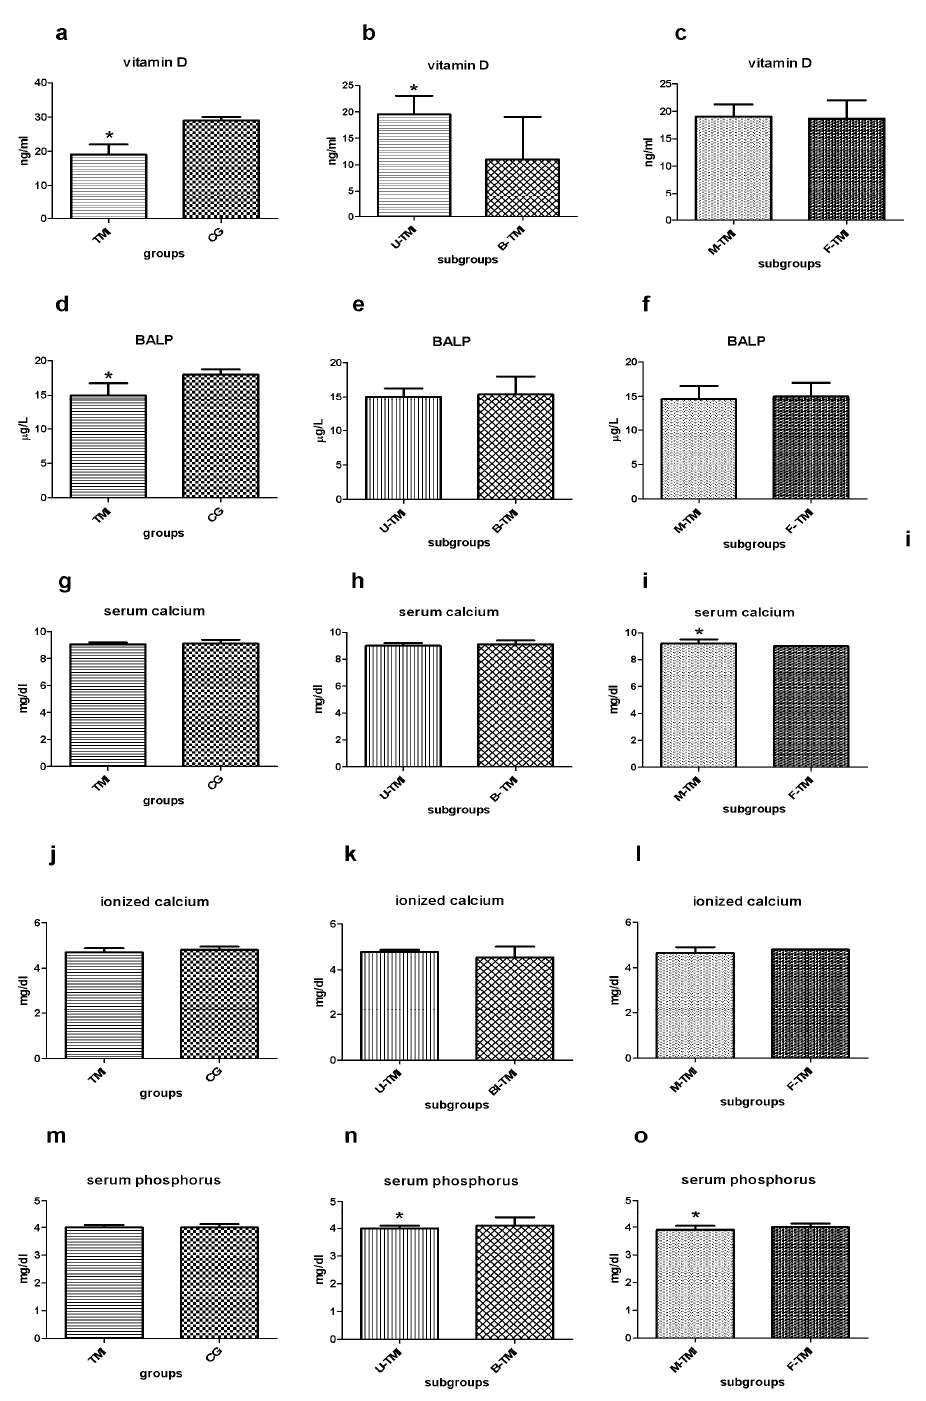
Figure 1. ( a – c ) Median with interquartile range of serum Vitamin D dosage (ng/mL) in TMI vs. CG ( a ), in U-TMI vs. B-TMI ( b ) and male vs. female TMI patients ( c ); ( d – f ) median with interquartile range of ionized calcium dosage ( µ g/L) in TMI vs. CG ( d ), in U-TMI vs. B-TMI ( e ) and M-TMI vs. F-TMI patients ( f ); ( g – i ) median with interquartile range of serum calcium dosage (mg/dL) in TMI vs. CG ( g ), in U-TMI vs. B-TMI ( h ) and male and female TMI patients ( i ); ( j – l ) median with interquartile range of ionized calcium dosage (mg/dL) in TMI vs. CG ( j ), in U-TMI vs. B-TMI ( k ) and male and female TMI patients ( l ); ( m – o ) median with interquartile range of ionized calcium dosage (mg/dL) in TMI vs. CG ( m ), in U-TMI vs. B-TMI ( n ) and M-TMI vs. F-TMI patients ( o ). Abbreviations CG control group, U-TMI unilateral third molar impaction, B-TMI bilateral third molar impaction, M-TMI third molar impaction for males, F-TMI third molar impaction for females; * denotes a significant statistically differences.